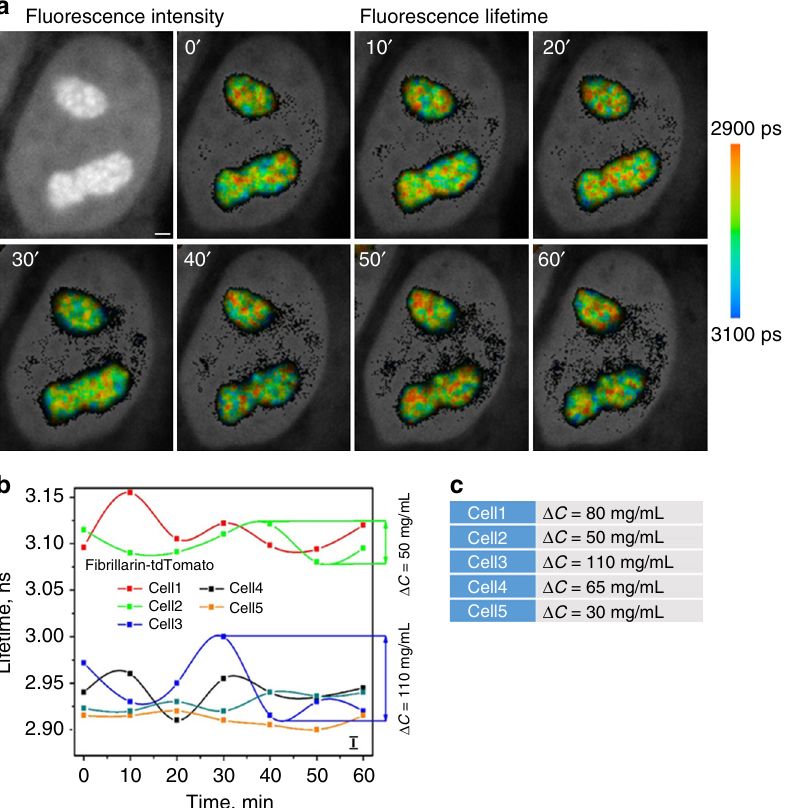
Fig. 3 Cyclic changes in absolute concentrations of nucleolar proteins. a Upper left panel represents fl uorescence intensity images of Fibrillarin-tdTomato in live cultured cell, other panels demonstrate fl uorescence lifetime data with 10 min intervals. Scale bar is 1 μ m. b Averaged fl uorescence lifetimes of tdTomato in nucleoli for fi ve cells are plotted over the time. Error bar in the bottom right corner shows the instrument measurement error. c Δ C demonstrates the amplitude of the protein concentration changes per cell as shown in charts on